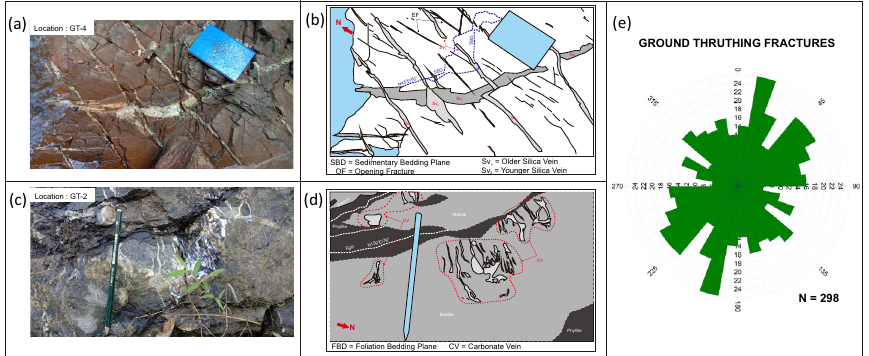
Fig. 12 Fracture observed and mapped in the study area. a Field photograph showing the different fracture sets observed in GT‑4; b schematic drawing of a ; c field photograph showing the fractures observed in of GT‑2; d schematic drawing of c ; e rose diagram showing the orientation of all fractures mapped in all ground‑truthing